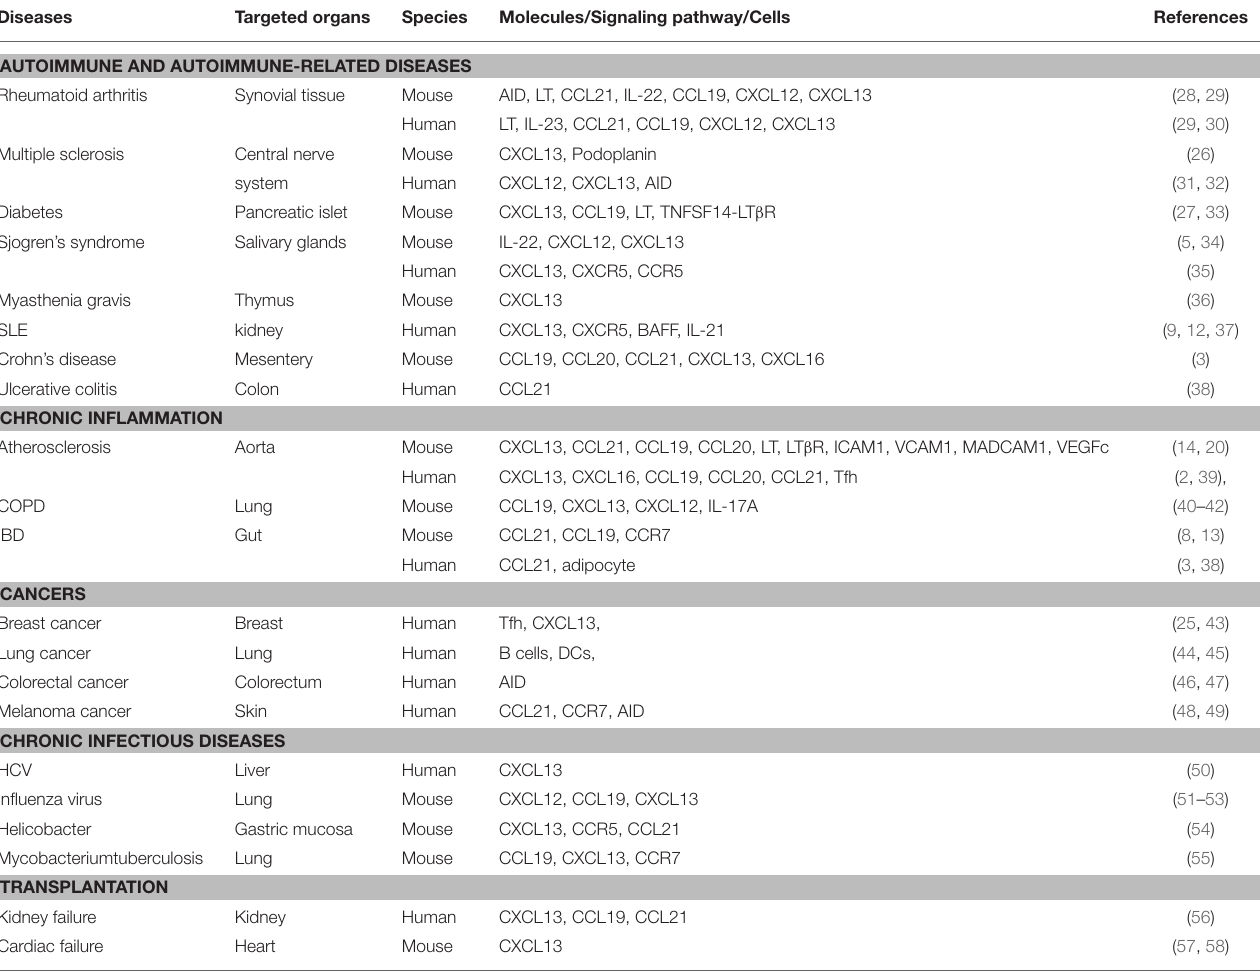
TABLE 1 | Molecular determinant of TLOs in chronic diseases and experimental